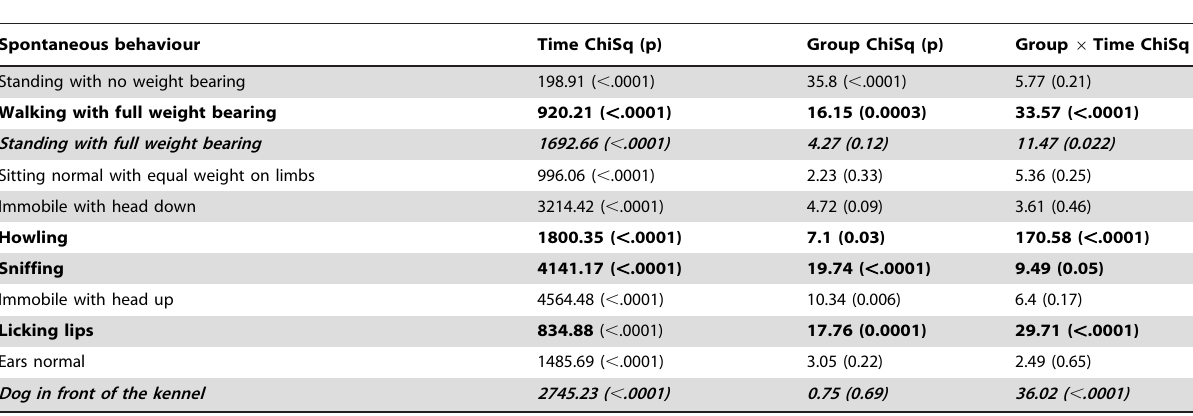
Table 2. Wald statistics for Type 3 GEE 1 analyses of